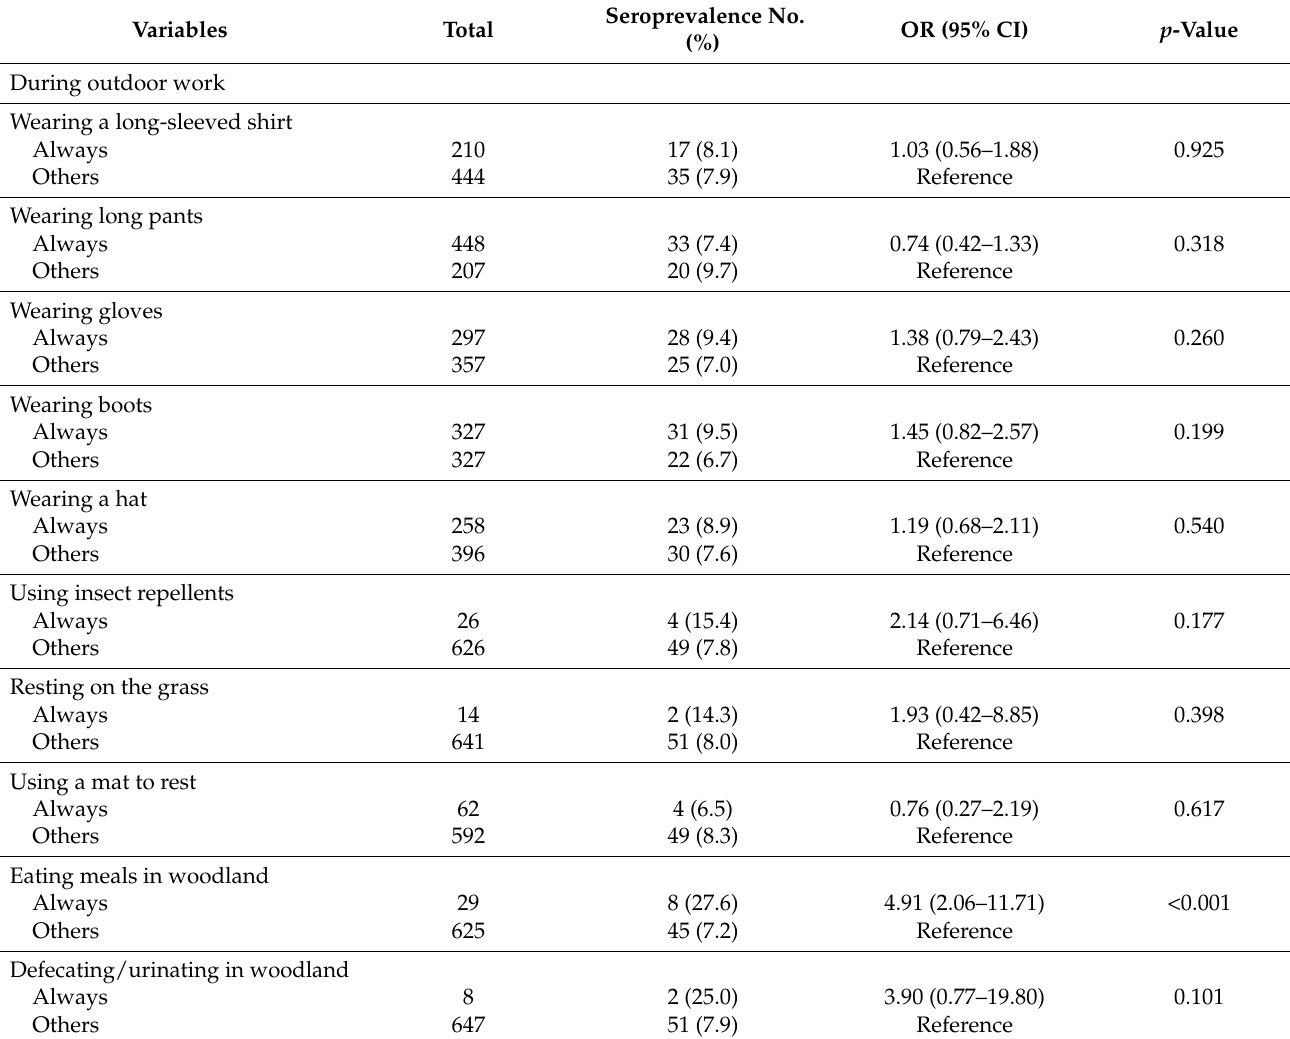
Table 4. Univariate logistic regression analysis between work hygiene-related factors and Lyme disease seroprevalence among National Park Office forestry workers in South